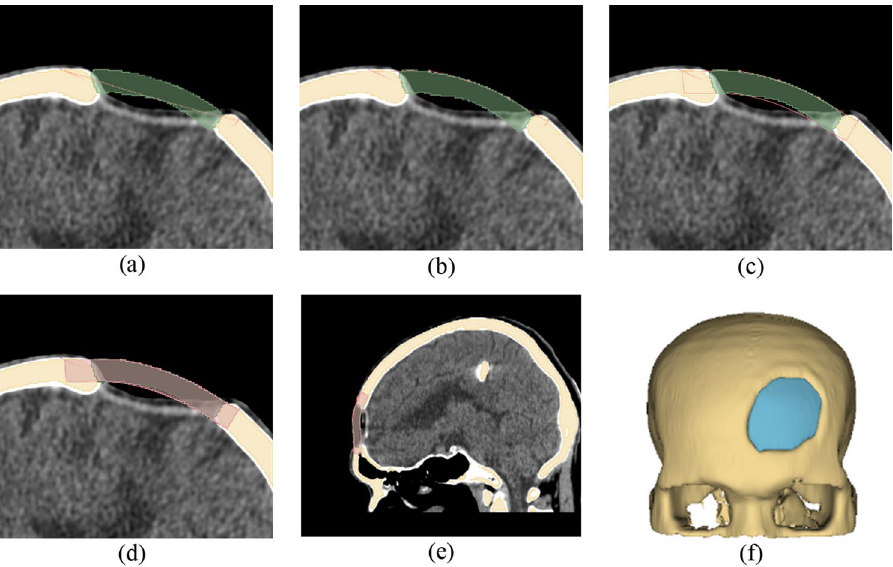
Figure 9. A Baffle based Mirror Guideline Method (BMG) ( a ) overlay the mirror implant model on the baffle planner layer ( b ) draw a curvature along the outer surface of the mirrored implant model ( c ) adjust model thickness to match the mirrored model ( d ) and ( e ) visualization of the combined mirror and baffle planner implant model on sagittal and coronal plane ( f ) final implant